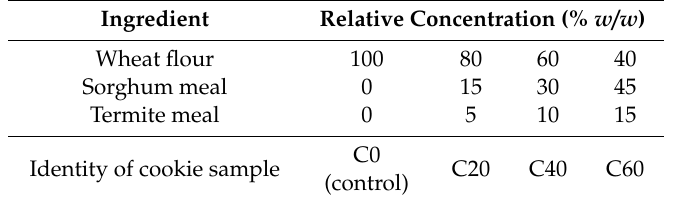
Table 1. Ratios of ingredients (wheat:sorghum and termite) for cookie formulation. Ingredient Relative Concentration (% w / w ) Wheat flour 100 80 60 40 Sorghum meal 0 15 30 45 Termite meal 0 5 10 15 C0 Identity of cookie sample C20 C40 (control)